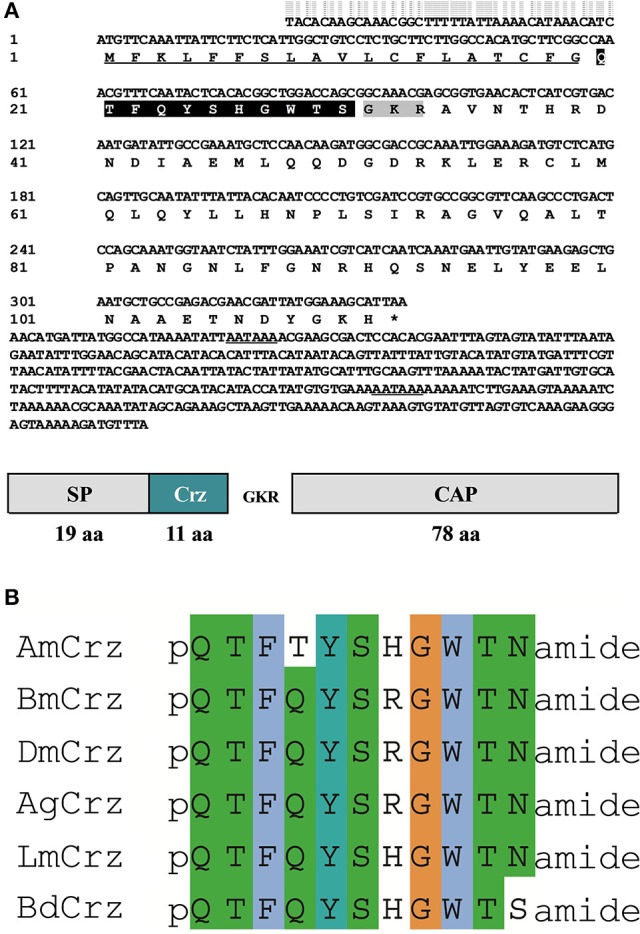
Crz precursor in B. dorsalis. (A) The cDNA and deduced aa sequence of BdCrz precursor. The underlined sequence indicates signal peptide (SP); highlighted in black represents mature peptide; shaded in gray is the putative cleavage site, followed by Crz-associated peptide (CAP). The putative polyadenylation signal in the 3′-noncoding region is underlined. (B) Alignment of aa sequence of Crz mature peptide in different insects. Corazonin of Apis mellifera (AmCrz, AFE02890.1), Bombyx mori (BmCrz, BAC66443.1), Drosophila melanogaster (DmCrz, NP_524350.1), Anopheles gambiae (AgCrz, AFE02890.1), and Locusta migratoria (LmCrz, AKN21243.1) were used for alignment.